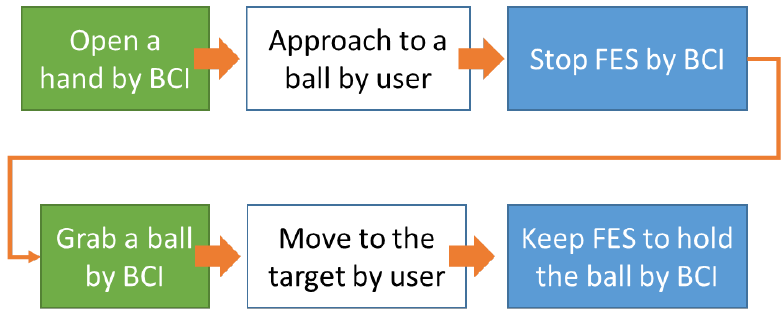
Figure 2. Sequence of the predefined tasks in Phase 2. BCI: Brain-Computer Interface.